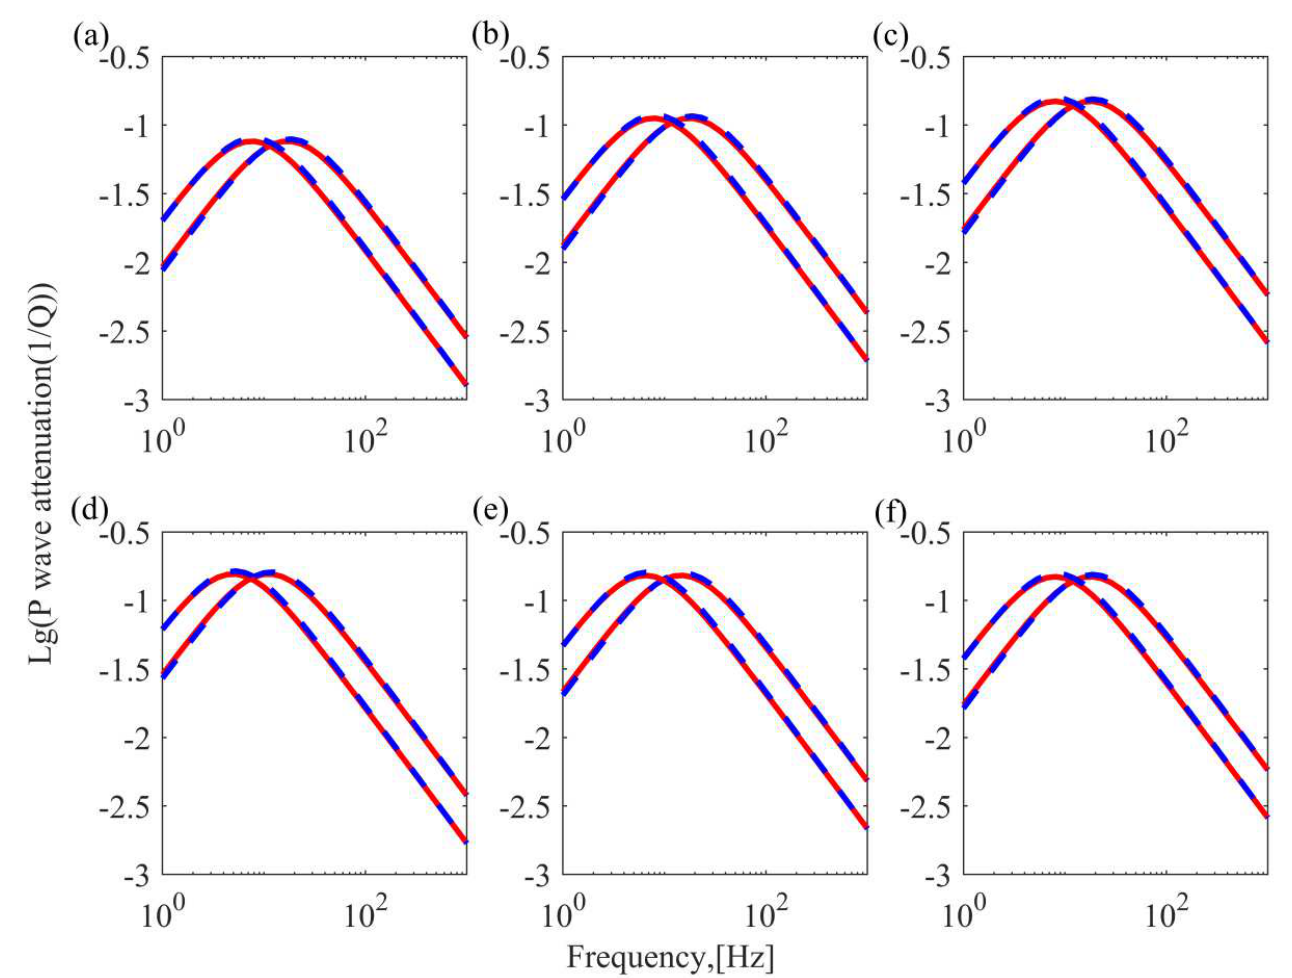
Figure 4. Comparison of 1/Q curves from the pore fluid dissolution model and the SLS model. The red solid curve is the pore fluid dissolution model, and the dash blue curve is the SLS mode. ( a ) Porosity 0.04 and gas saturation 0.25%, ( b ) Porosity 0.06 and gas saturation 0.25%, ( c ) Porosity 0.08 and gas saturation 0.25%, ( d ) Porosity 0.08 and gas saturation 0.15%, ( e ) Porosity 0.08 and gas saturation 0.2%, ( f ) Porosity 0.08 and gas saturation 0.25%.